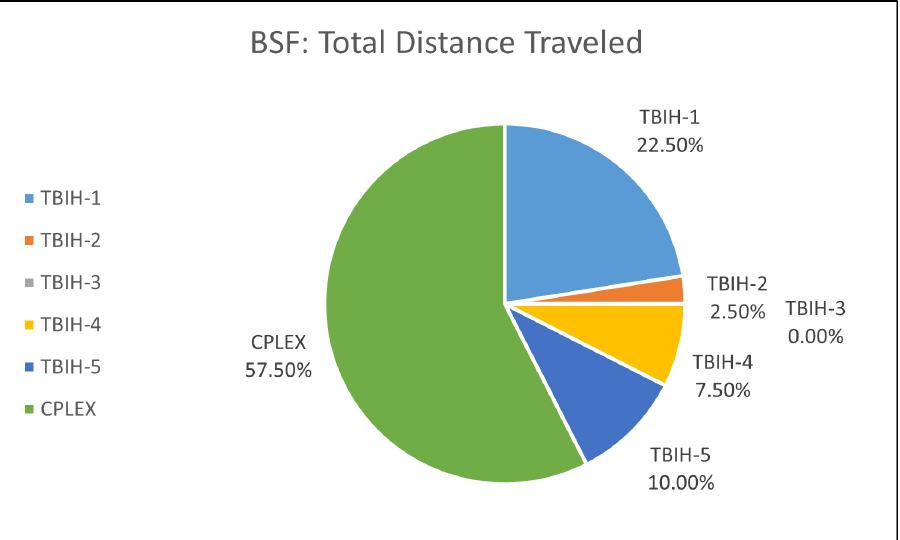
Figure A20. Algorithms performance compared to matheuristic rollout applied in PDS-RA: total BSF measured for total travelled distance over all test instances applied (omitting 10 non-benchmarked measurements).